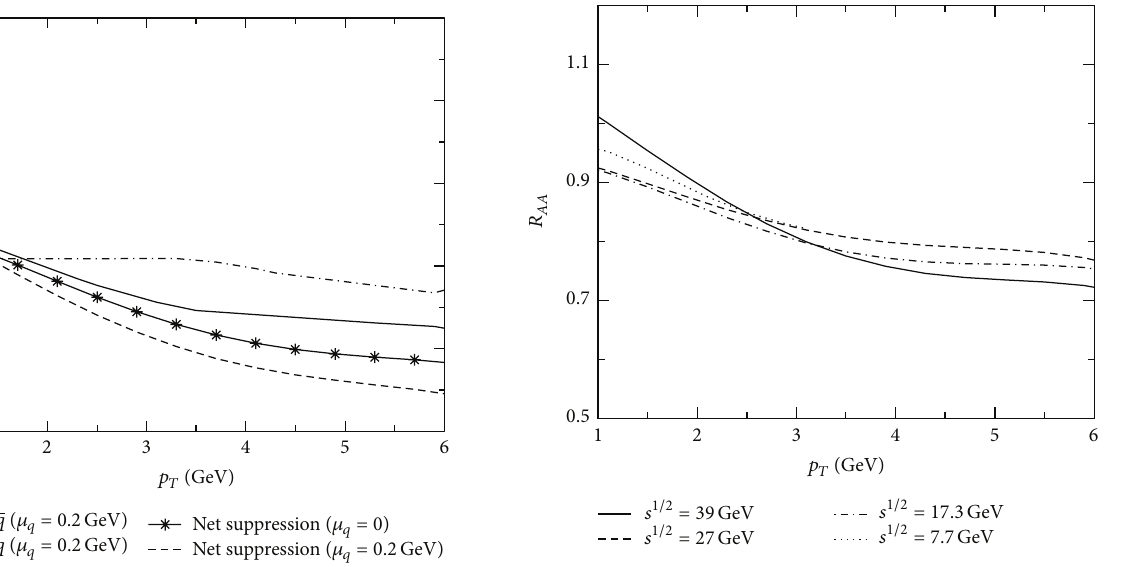
Figure 17: The nuclear suppression factor 𝑅 𝐴𝐴 as a function of 𝑝 𝑇 due to the interaction of the charm quark (solid line) and anti-quark (dashed-dot line) for 𝜇 = 200 MeV. The net suppressions including the interaction of quarks, anti-quarks, and gluons for 𝜇 = 200 MeV (dashed line) and 𝜇 = 0 (with asterisk) are also shown.